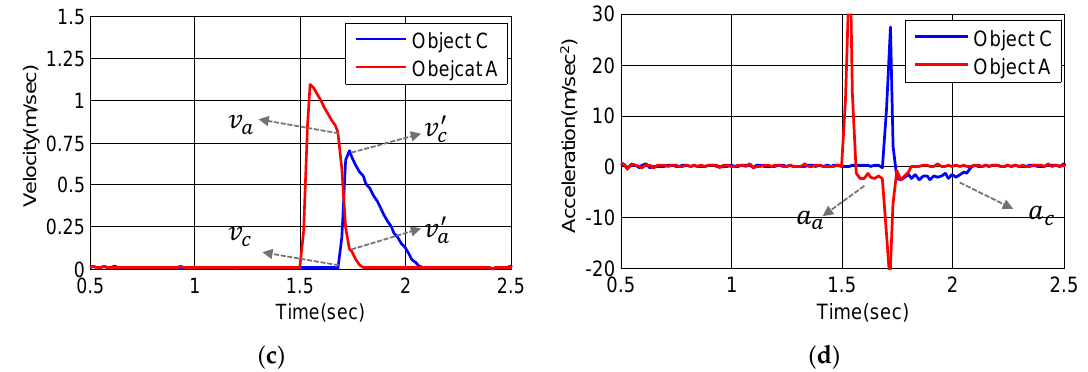
Figure 6. Setup, objects, and observed parameters from collision of two objects. ( a ) Setup and object involved in scattering application. ( b ) Observed displacements. ( c ) Observed velocities. ( d ) Observed accelerations.